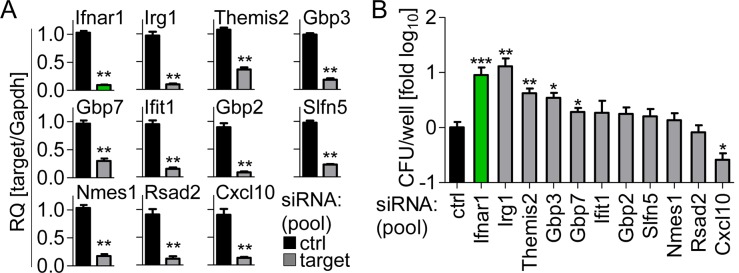
RNAi screen identifies IRG1 as crucial L. pneumophila restricting factor.(A, B) BMMs were transfected with control siRNA or a pool of two siRNAs per gene 24 h prior to infection and infected with L. pneumophila. Expression of targeted genes was assessed 24 h p.i. by qRT-PCR (A), and CFUs were counted 72 h p.i. (B). Data are mean + s.e.m. of 2 (A) or 4 (B) independent experiments done in triplicates. * p<0.05, ** p<0.01, *** p<0.001, no indication if not significant (Mann-Whitney U test).